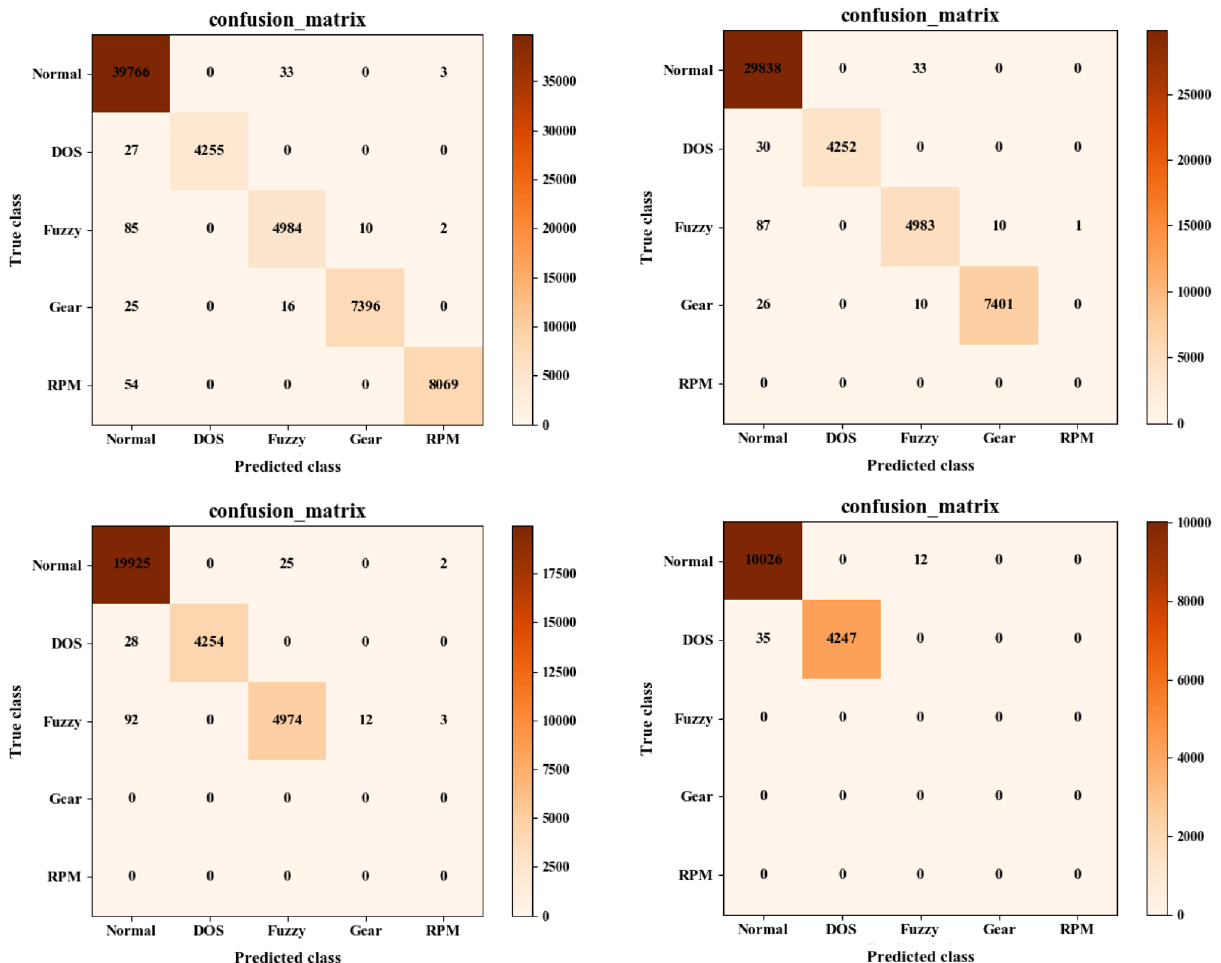
Figure 11. Results of the typical confusion matrices using Mosaic coding for 29-bit CAN ID. The numbers in the confusion matrix represent the number of samples from the original category represented by the horizontal axis being classified into the category represented by the vertical axis. For example, the intersection between Fuzzy (vertical) and Normal (horizontal) represents the number of Normal samples wrongly classified by the model as